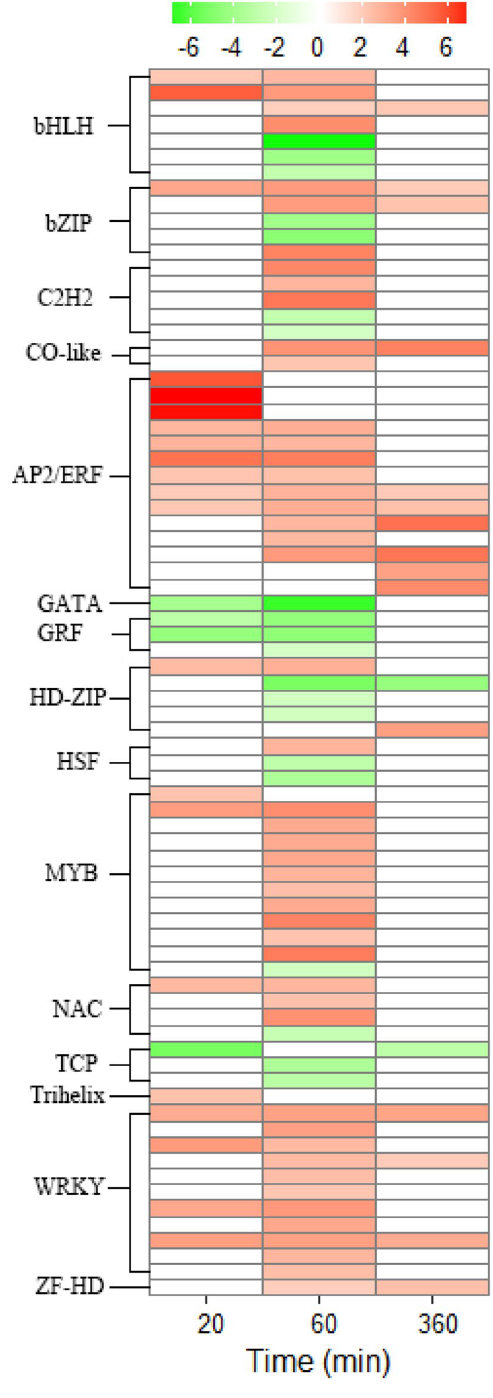
Figure 4. Detailed expression profile of DEGs related to transcription factors at three time points. Heat maps illustrating the relative expression levels of genes encoding transcription factor obtained from MSU Rice Genome Annotation Project Release 7 (http://rice.plantbiology.msu.edu/). Red and green colors depict up- and down-regulation relative to control (light/dark), respectively. The scale shows log2 fold